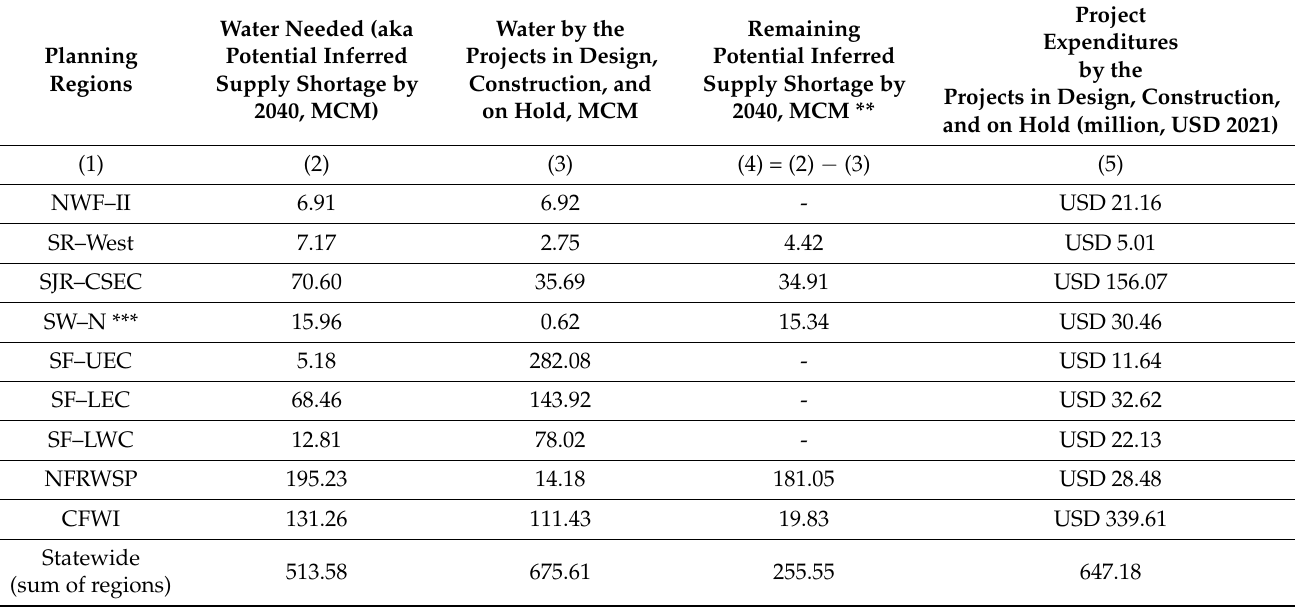
Table 3. Analysis of the Recently Completed Projects and Projects in Construction, in Design, and On Hold, by Regions with Water Shortages